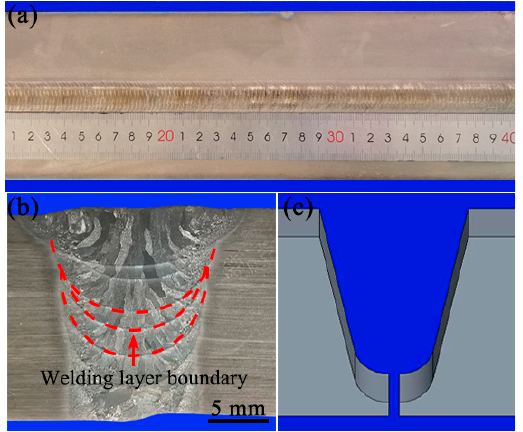
Figure 1. Macro-morphology of the welded joint: ( a ) surface morphology, ( b ) section morphology, and ( c ) welding groove.